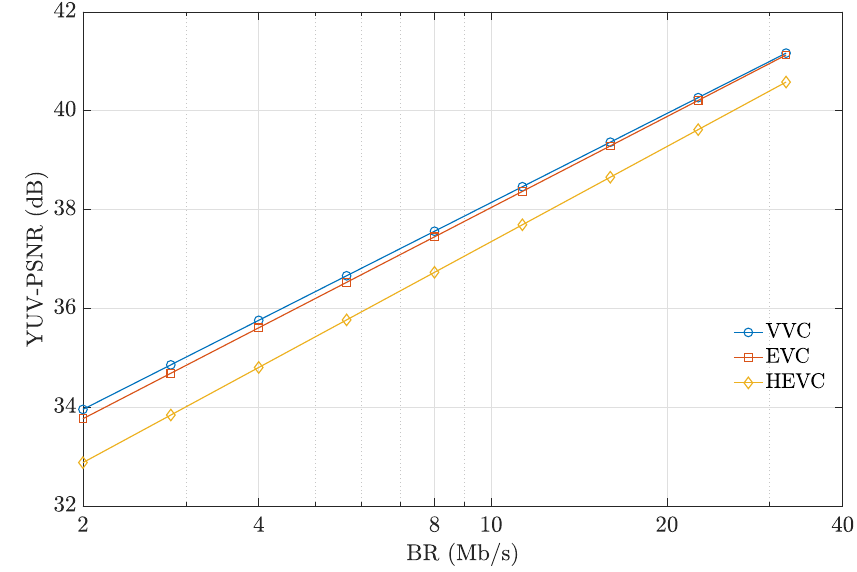
Figure 4. Codec comparison for 3840 × 2160 resolution sequences.